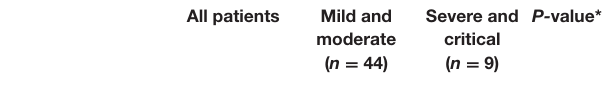
TABLE 1 | Baseline information of COVID-19 patients enrolled in this study.